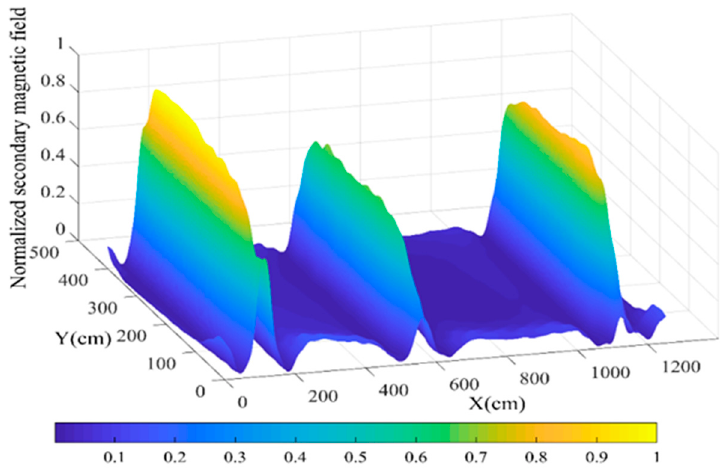
Figure 18. Normalized image of the measurement results for the induced magnetic field.